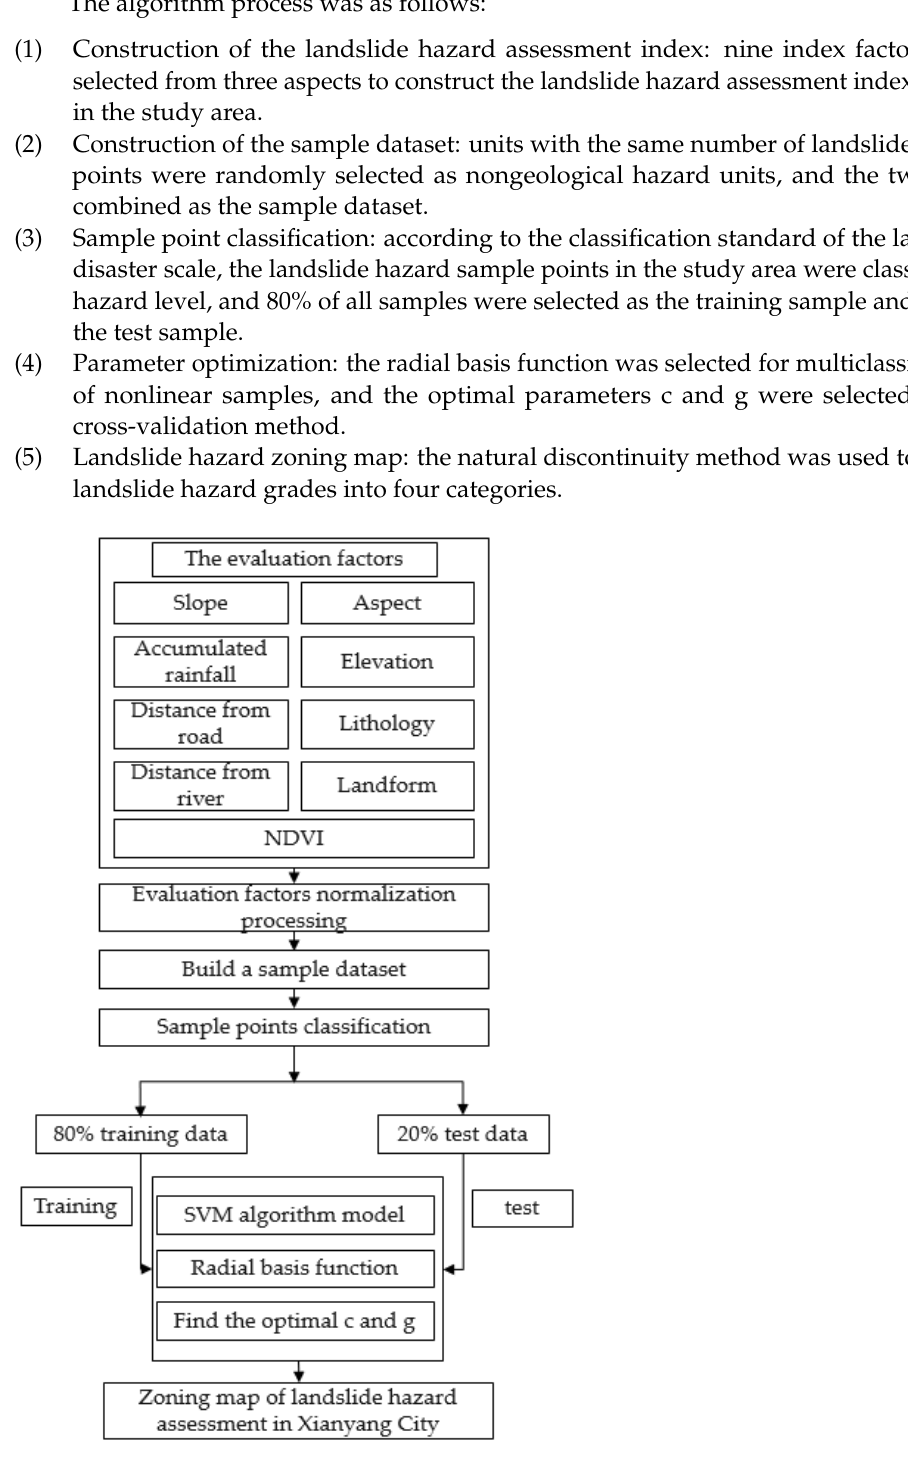
Figure 5. Flowchart of landslide hazard assessment in Xianyang City.